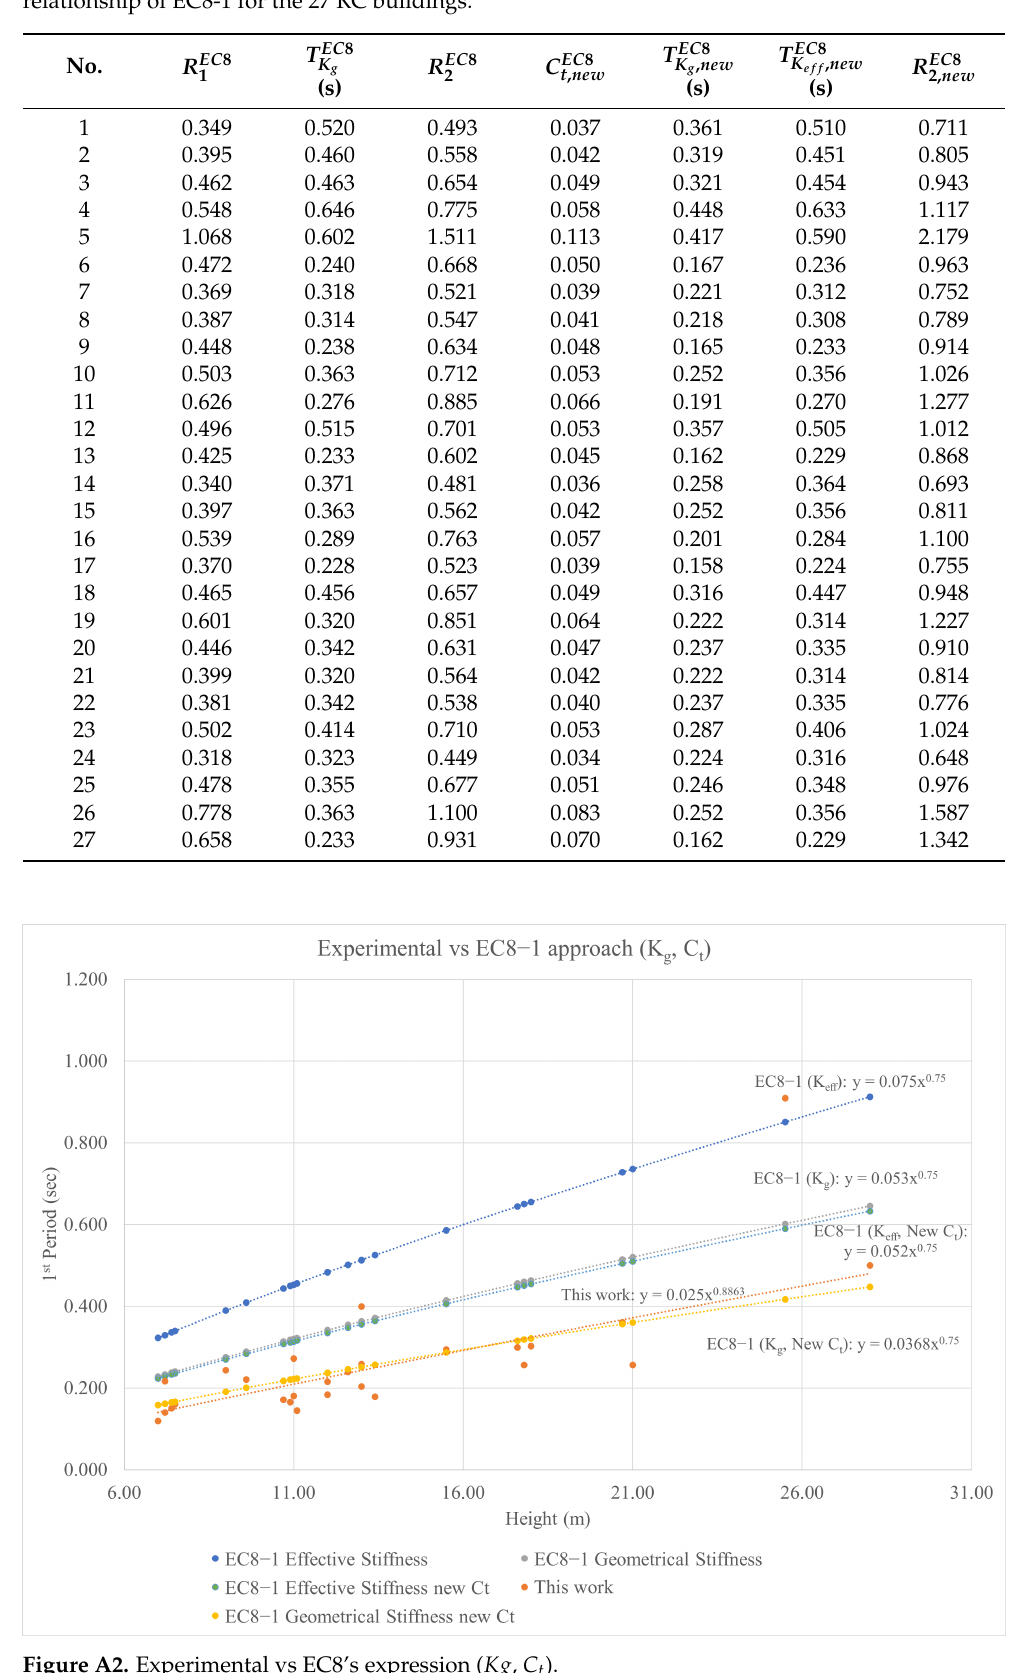
Table A2. Investigation on the C t value used for estimating the effective 1st period based on empirical relationship of EC8-1 for the 27 RC buildings.